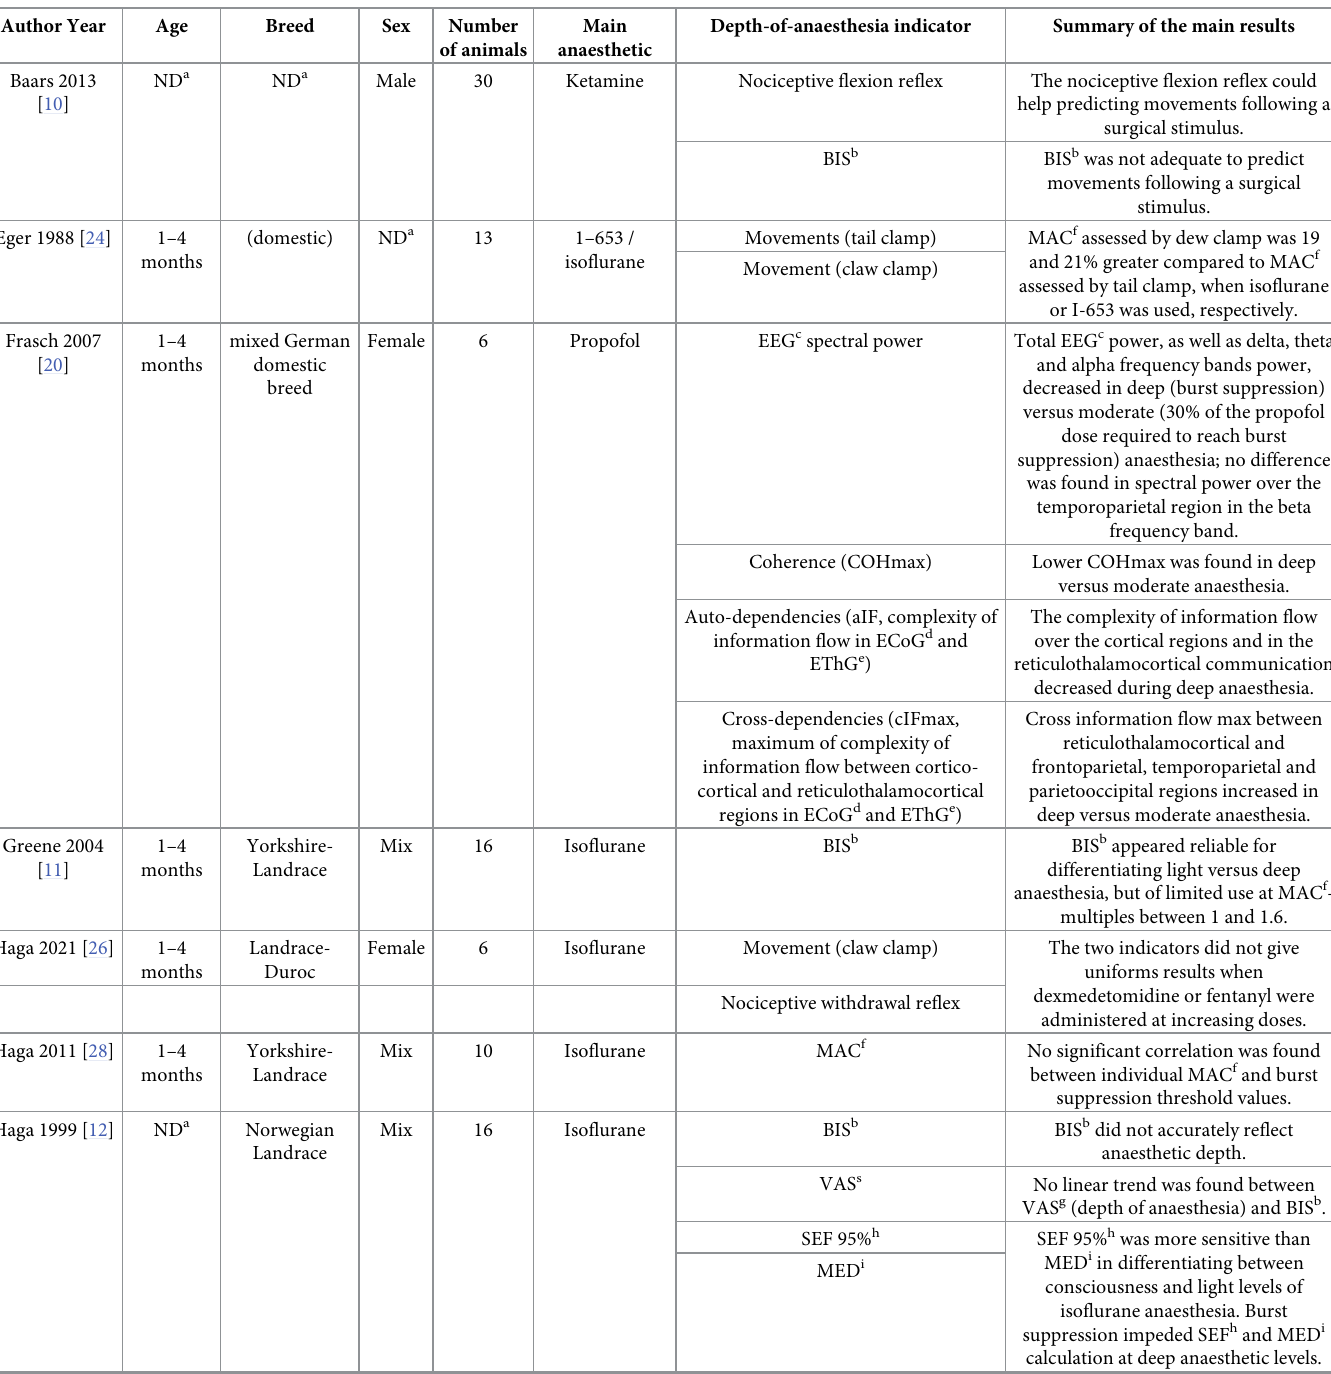
Table 3. Category A depth-of-anaesthesia indicators, relative studies and summary of the main